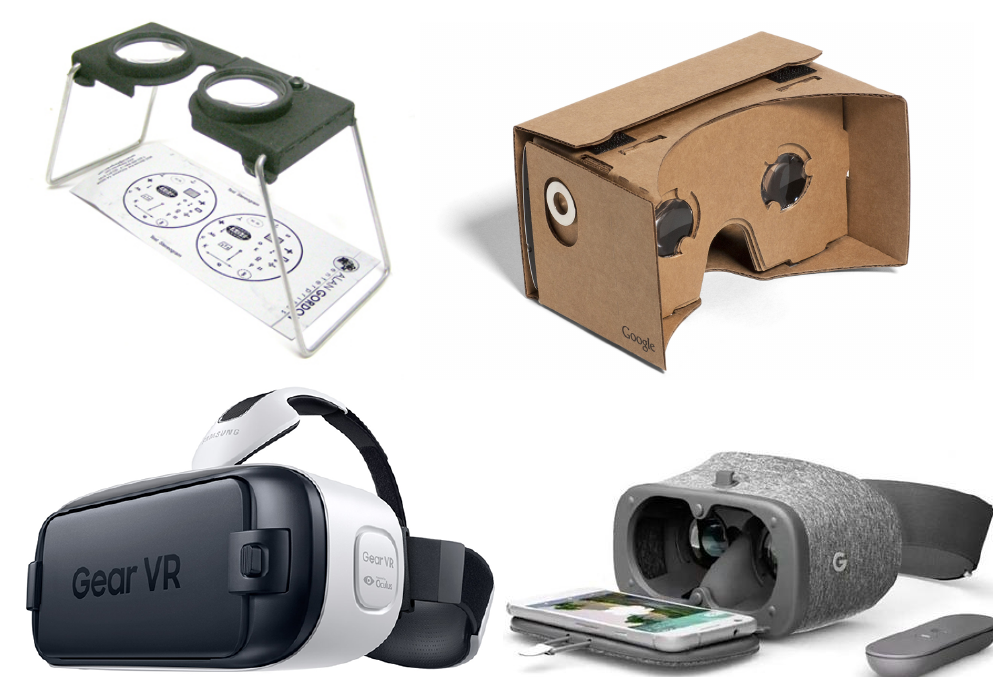
Figure 1. A portable pocket stereoscope [2], a low-cost Google Cardboard [3], a Samsung Gear VR